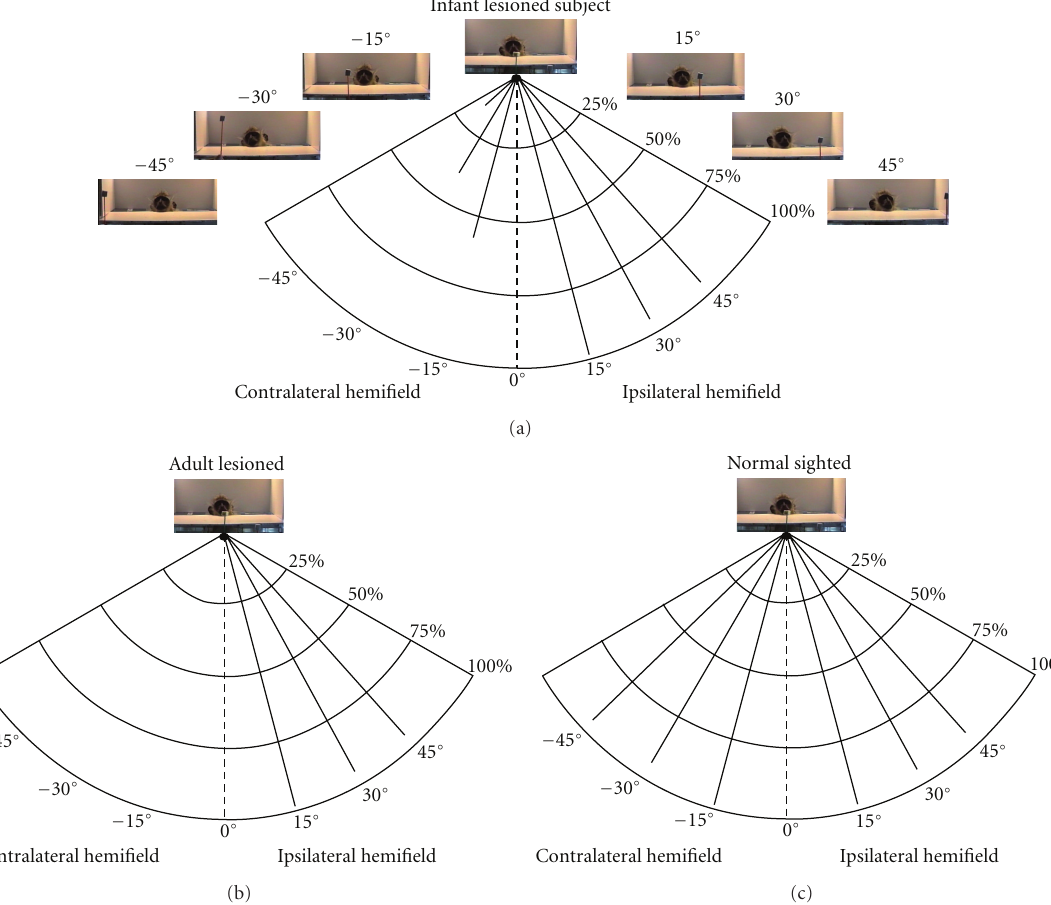
Figure 2: Perimetry: infant-lesioned monkeys (a) were able to detect visual stimuli at 45 ◦ in the “blind” hemifield, whereas no visual response could be elicited in the adult-lesioned subjects (b) in the contralateral hemifield. Normal-sighted monkeys had a 75% visual perimetry at 90 ◦ in both hemifields (c) (adapted from